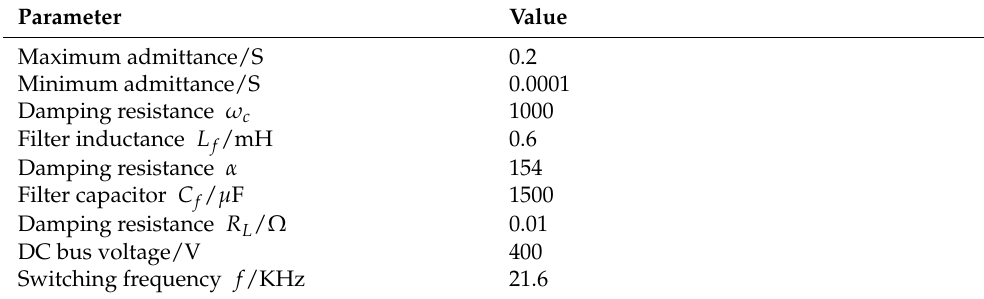
Table 1. Relevant parameters set by the